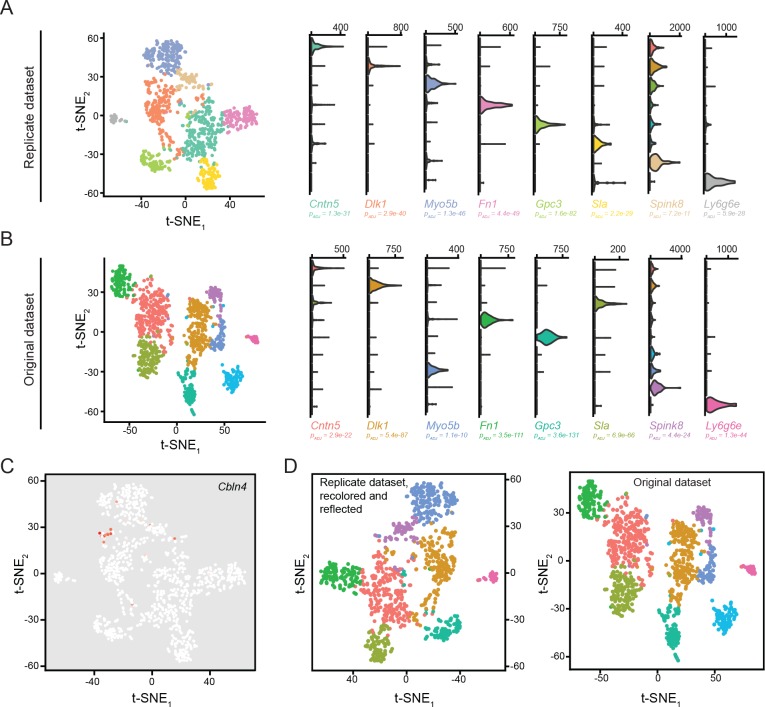
Reproducibility of clusters across biological replicates.(A) Left: t-SNE visualization of cells and clusters identified in an independent dataset of biological replicates. Right: marker genes associated with eight obtained clusters in replicate dataset. (B) Left: t-SNE visualization of cells and clusters used in main text of manuscript (‘original dataset’). Right: expression of replicate marker genes in the original dataset. (C) Visualization of Cbln4 expression, the sole cluster not captured in the replicate dataset. (D) Left: t-SNE visualization of replicate dataset, reflected in y axis and recolored according to cluster correspondence with original dataset. Right: t-SNE visualization of original dataset, for comparison.